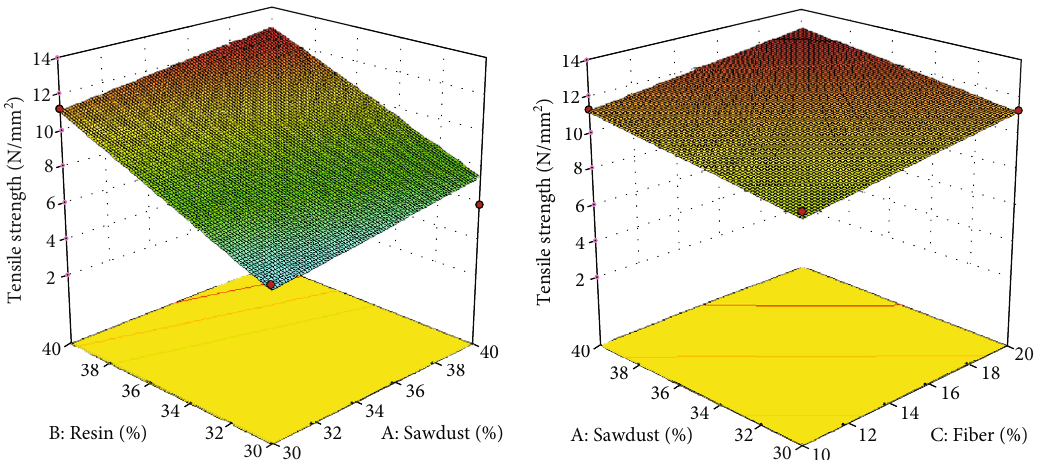
Figure 2: E ff ect of fi bres, sawdust, and resin on tensile strength of the